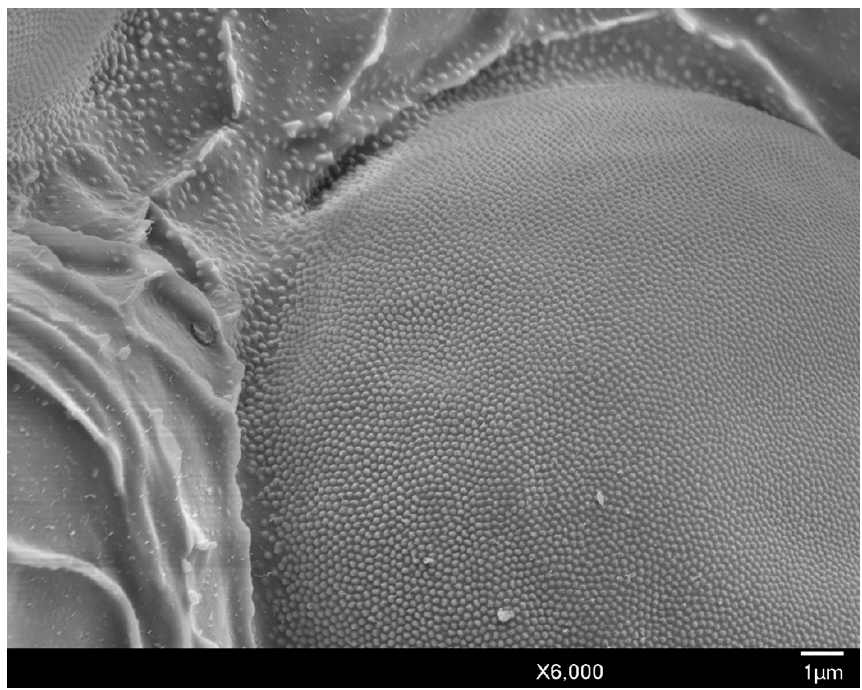
Figure 6. SEM close-up of the granular surface of the head and dorsal simple eye of male A. galliformis . Antennae: The filiform, has 10 segments, with distinct scape (scp) and pedicel (pdc); the total antennal length is 500–584 µ m (mean 529 µ m); the mean ratio of body length to antennal length is 1:1.94 µ m. The antennal segments all bear numerous long setae. The scape is 32–55 µ m (mean 41 µ m) in length, widest at the base 38–44 µ m (mean 41 µ m), with few setae. The pedicel is 46–53 µ m